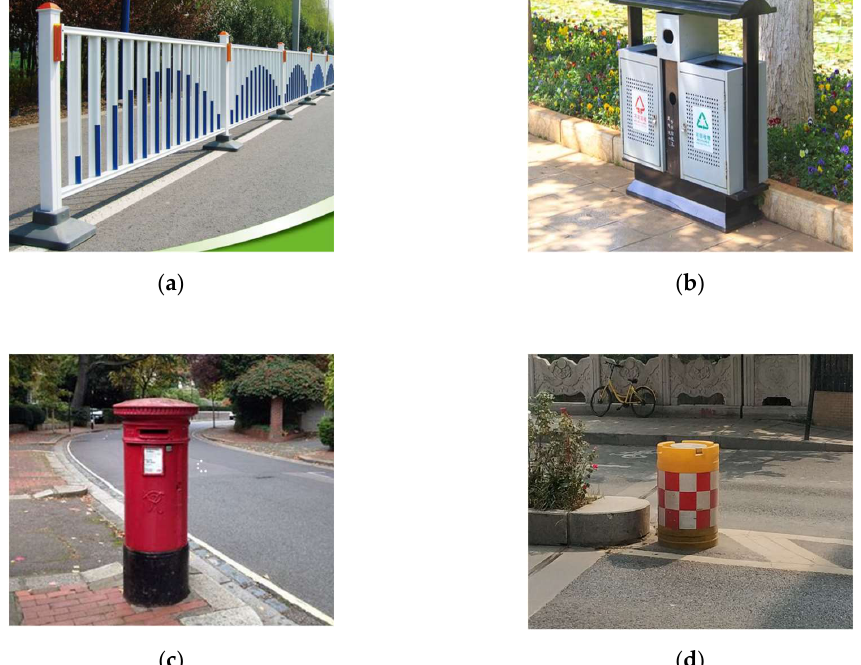
Figure 1. Some types of ubiquitous reference objects, e.g., pavement fence ( a ), ashbin ( b ), post box ( c ), and traffic bucket ( d ).